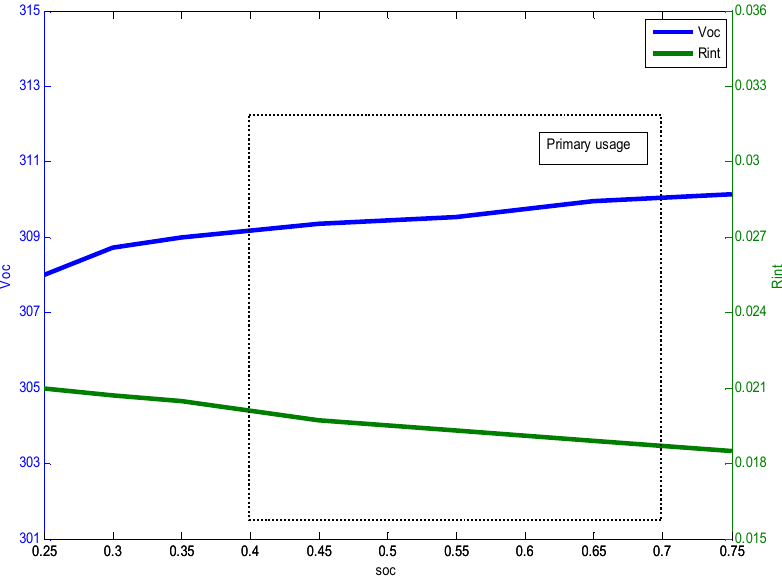
and R varying as soc oc int